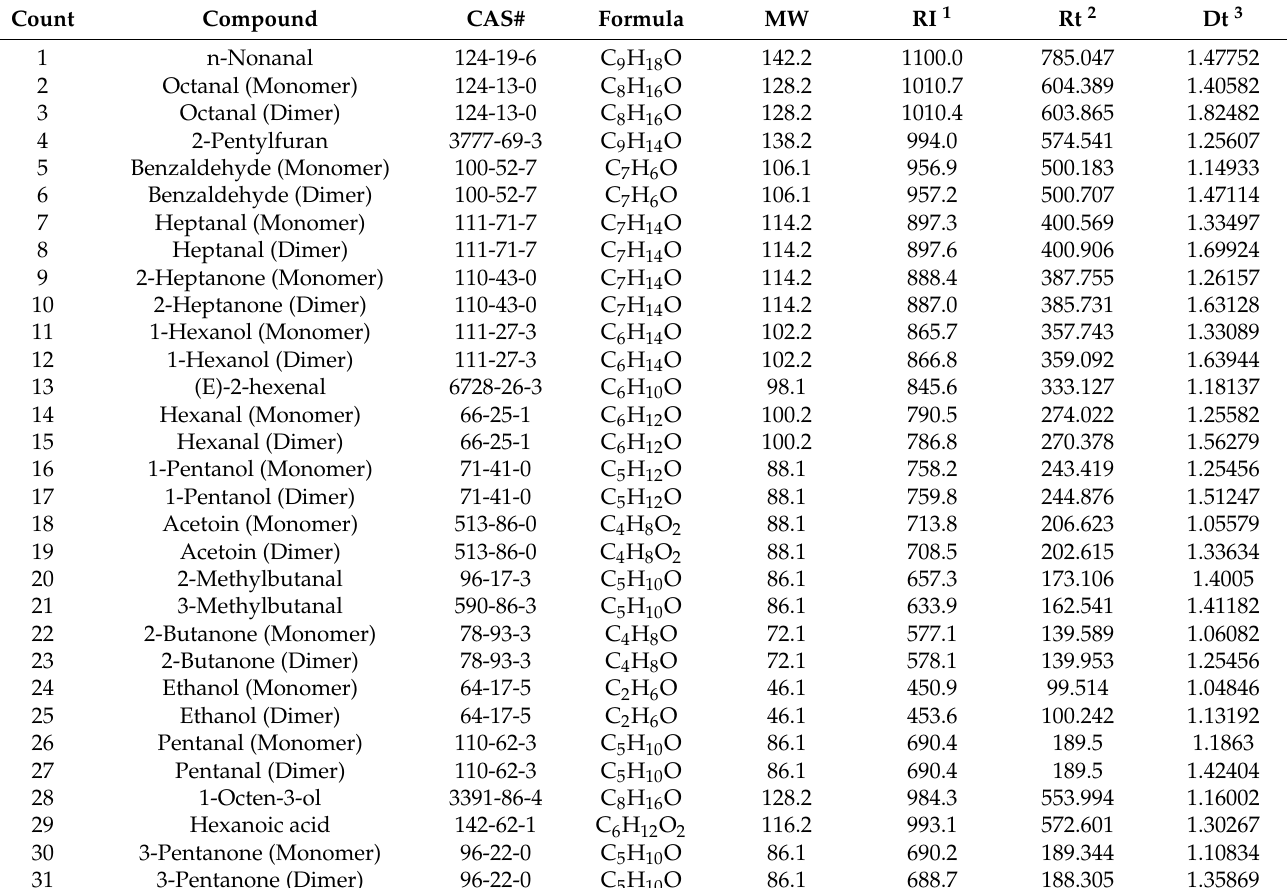
Figure 6. Topographic plots of GC–IMS spectra ( A ) with the selected markers obtained and fingerprint ( B ) comparison of VOCs with samples in different fried temperatures with a moisture content of 65%. Note: In the fingerprint, the darker the spot is, the larger is the quantity of volatile compounds. Each row represents all the signal peaks selected in a sample. Each column represents the signal peak of the same volatile compounds in different samples. Table 1. Volatile organic compounds from fish filets under different fried conditions with a moisture content of